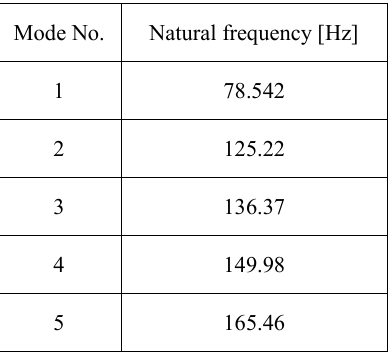
Table 1. Natural frequencies Mode